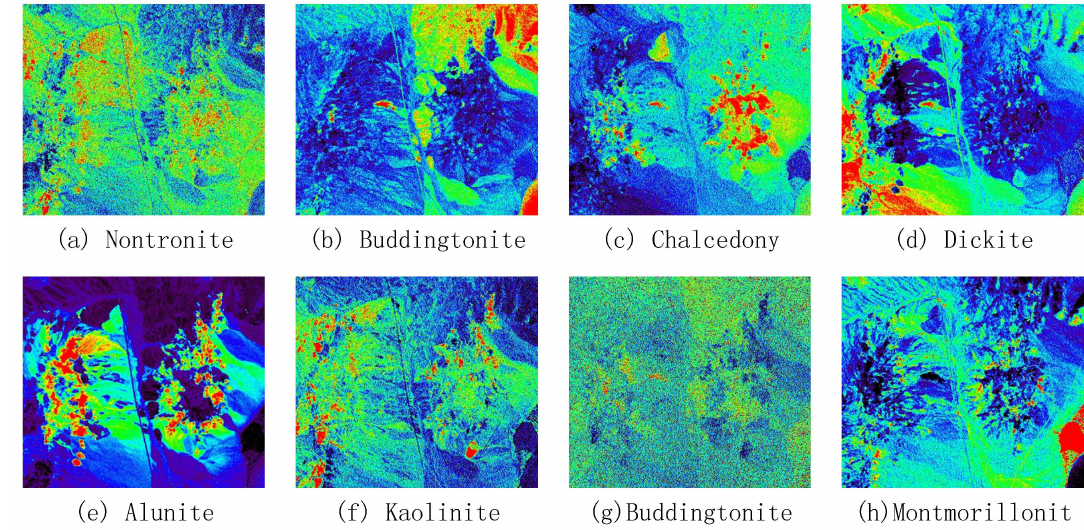
Figure 9. ABCEE-R abundance inversion results for the Cuprite data. ( a ) Nontronite; ( b ) Buddingtonite; ( c ) Chalcedony; ( d ) Dickite; ( e ) Alunite; ( f ) Kaolinite; ( g ) Buddingtonite;